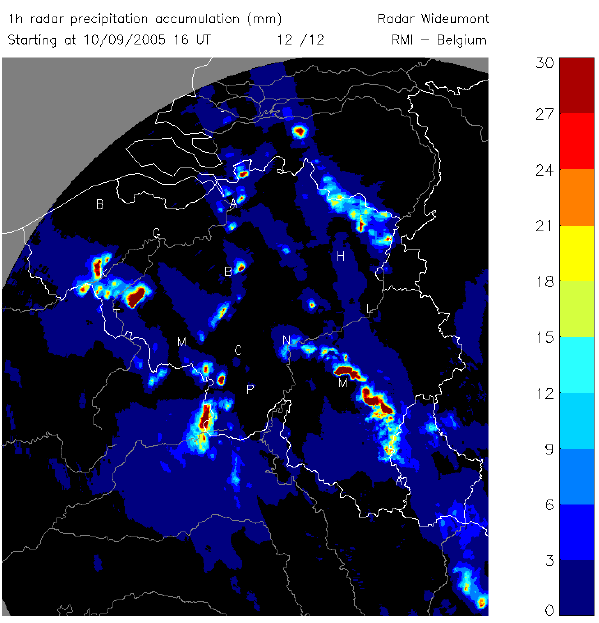
Fig. 1. 1h accumulated precipitation – thunderstorm of 10 Septem- ber 2005, Wideumont Radar, Fig. 1.